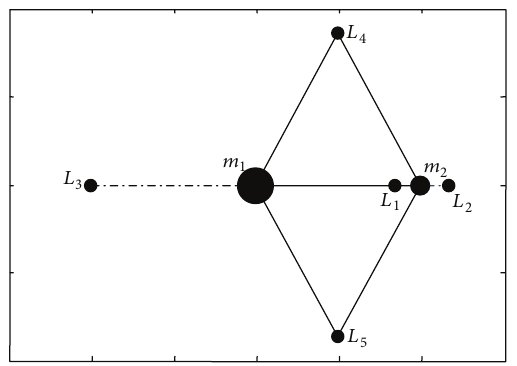
Figure 1: Hyperbolic equilibria in circular restricted three-body problem: The three collinear equilibria are hyperbolic, labeled as , 𝐿 𝐿 𝐿 1 2 , and 3 . The equilibria in CR3BP are renamed as libration